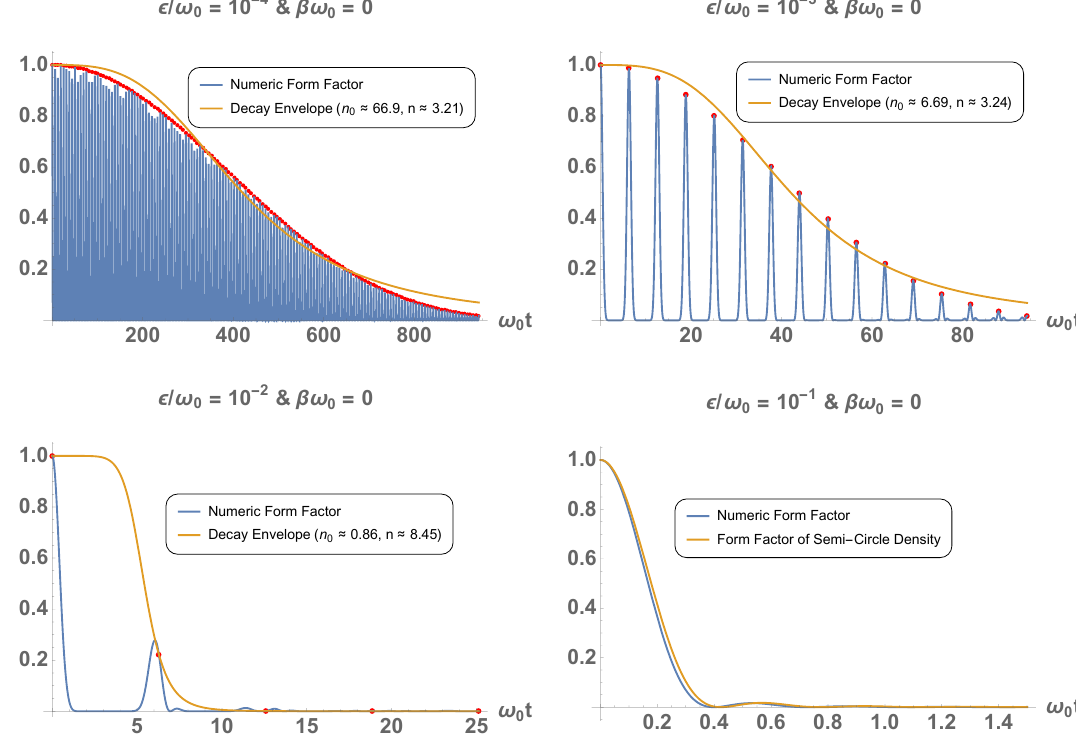
Figure 15 . The plots in the figure above depicts the self averaging early time behaviour in the infinite temperature form factor computed numerically for a system of 11 fermionic oscillators coupled together by a ( 2 11 × 2 11 ) random GUE matrix for various values of (cid:15)/ω 0 ranging from 10 − 4 to 10 − 1 . The blue line depicts the numerical calculation of the form factor for a single sample (due to the self averaging behaviour at early times one can check the single sample will agree with the numerical average to high precision). The red dots indicate the value of the form factor at regularly spaced time intervals given by ω 0 t k = 2 πk . The yellow line is a numeric fit of the red data points to a function given by eq. (4.18) with fitting parameters n 0 , n (shown in the legend of the plots). For the bottom right plot we compare the numeric early time behaviour to the behaviour predicted by eq. (4.19), which is the form factor of a semi-circle spectral